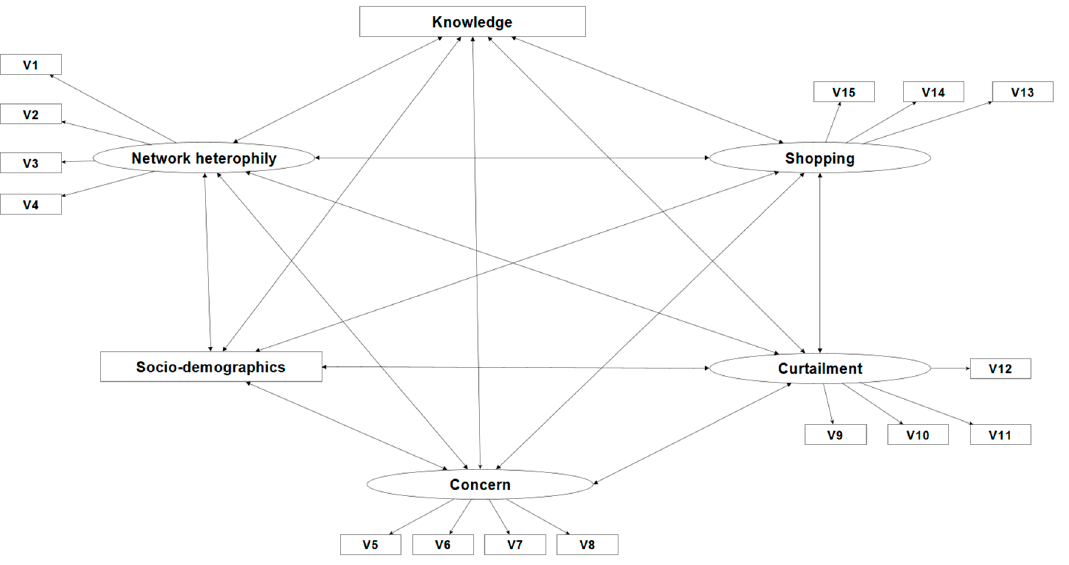
Figure 1. Measurement model used to: (i) evaluate latent constructs and (ii) examine bivariate association. Model fit: χ 2 = 387.385 df = 161, p ≤ 0.001; CFI = 0.979; SRMR = 0.029; RMSEA = 0.032.